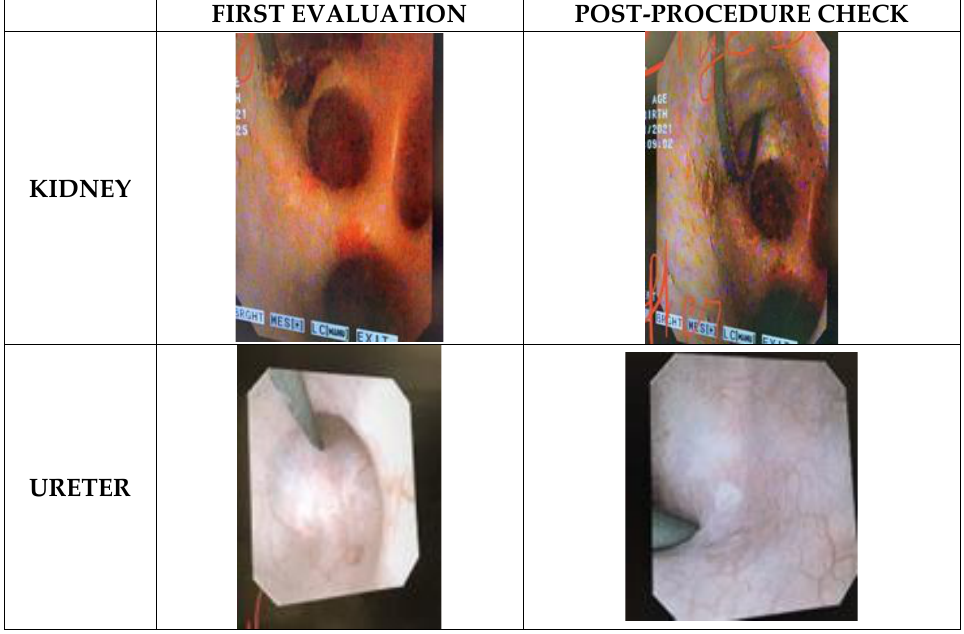
Figure 3. Endoscopic images captured during first evaluation and three weeks later, for kidney and ureter sites. Subjectively no differences were found endoscopically between TFL and Ho:YAG during per-procedure and post-procedure safety check.